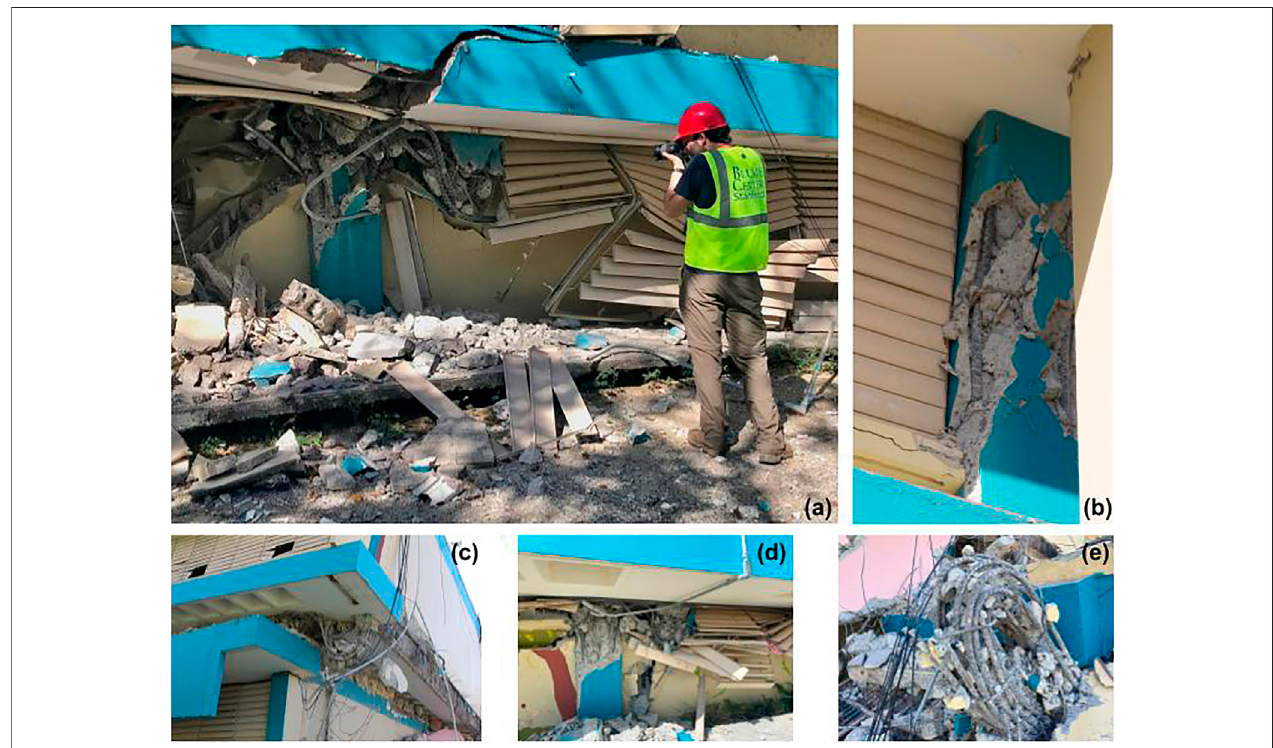
FIGURE 7 | Collapsed Agripina Seda School in Guánica, Puerto Rico: ( A ) in-depth photographic documentation with inset examples of load path vulnerabilities to ( B ) captive columns, ( C-D ) soft-story failure and ( E ) mangled reinforcement from crushed column.